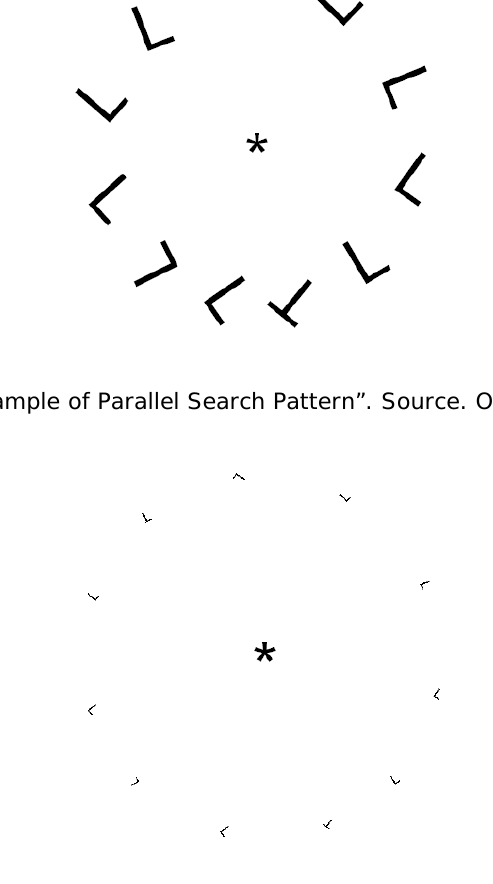
Figure 2. “Example of Serial Search Pattern”. Source. Own